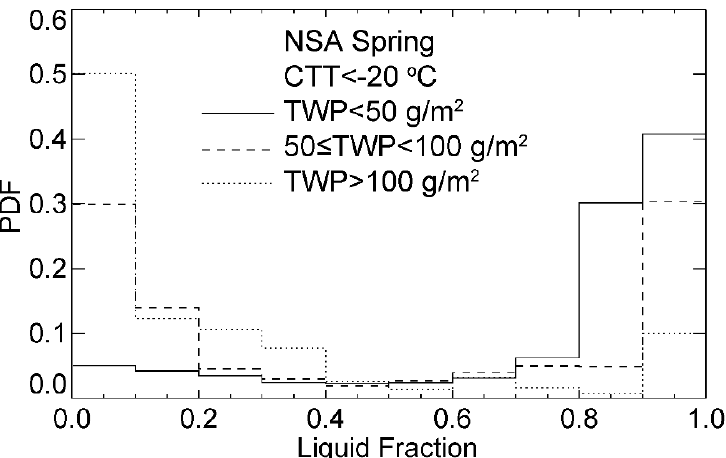
Figure 5. PDF of the liquid fractions for NSA clouds with CTTs below − 20 °C during spring.